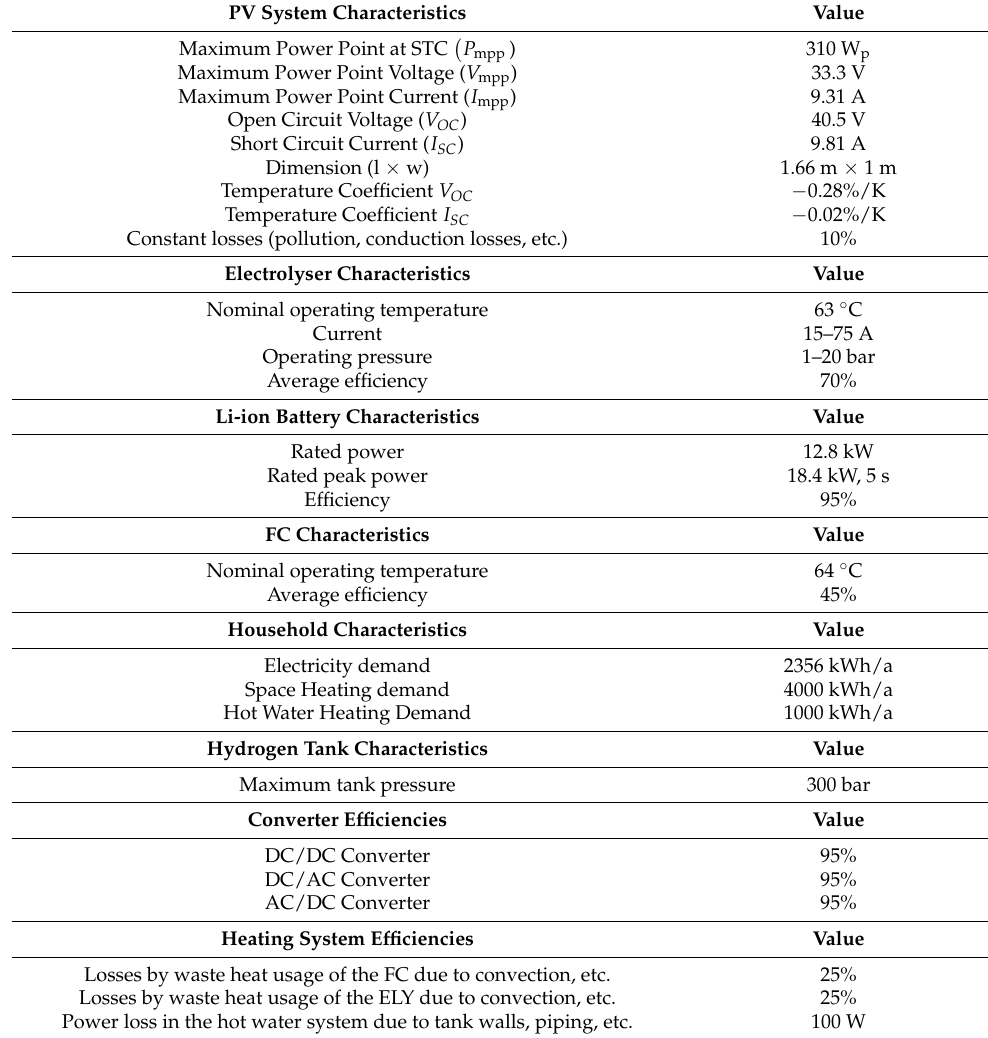
Figure 16. Histograms of the power distributions under different ELY dimensionings (5 kW ( left ), 3 kW ( middle ) and 2 kW nominal power ( right )).